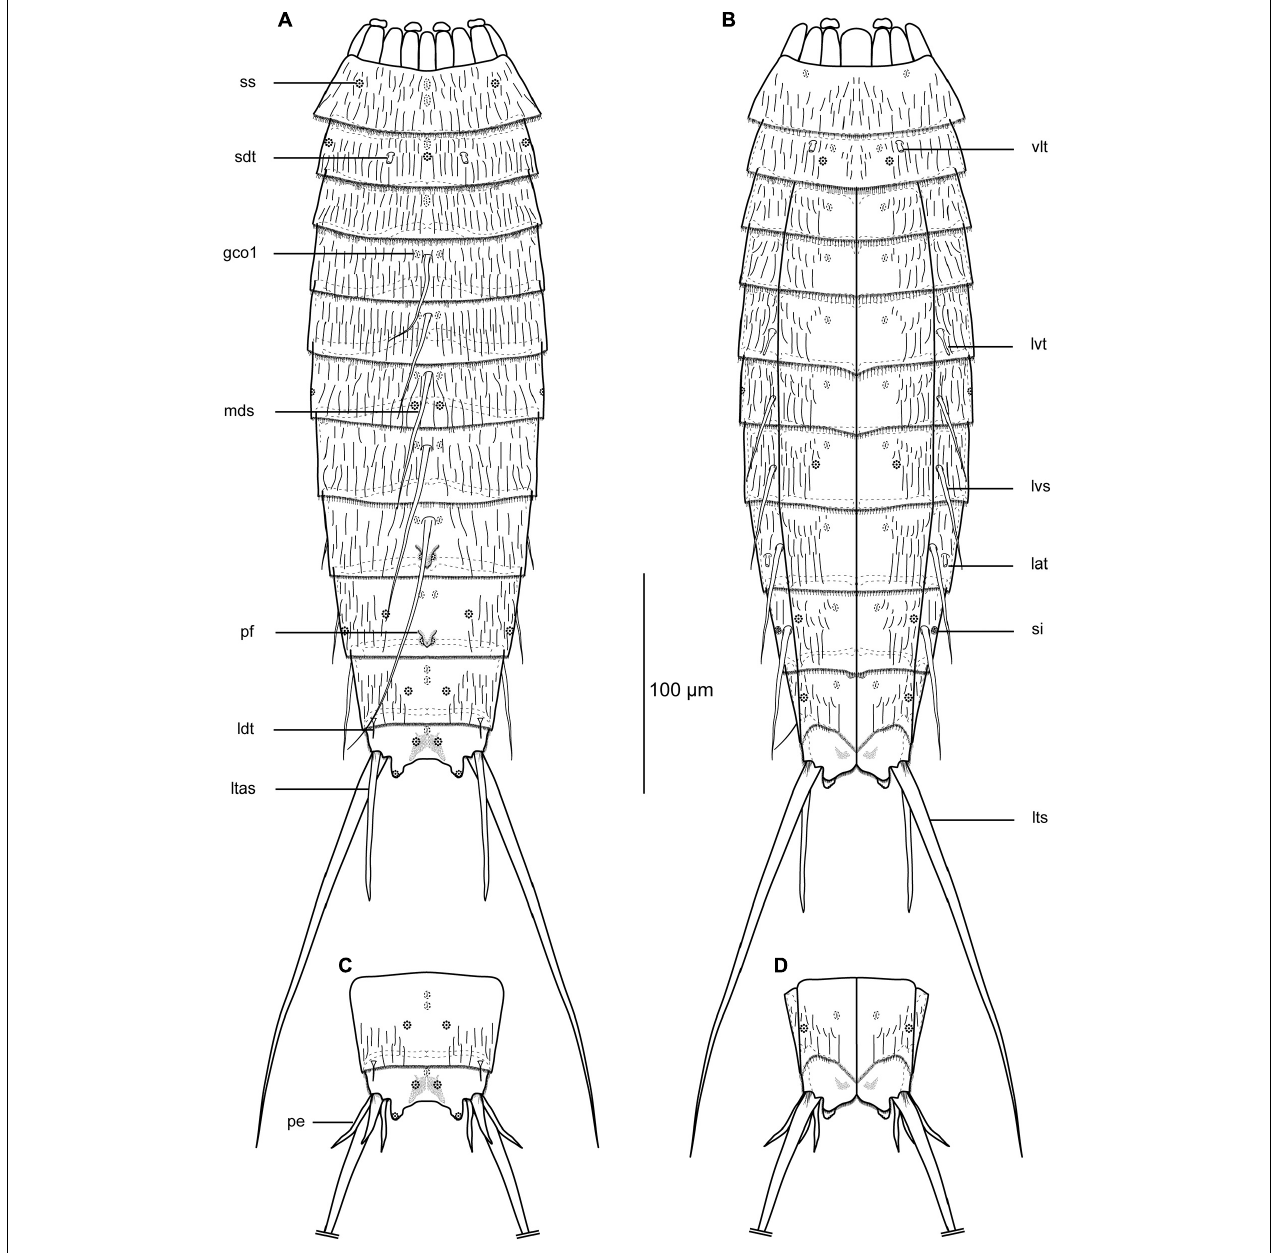
FIGURE 2 | Line art illustrations of Echinoderes mamaqucha sp. nov. (A) female, dorsal view; (B) female ventral view; (C) male, segments 10–11, dorsal view; (D) male, segments 10–11, ventral view. gco1 , glandular cell outlet type 1; lat , lateral accessory tube; ldt , laterodorsal tube; ltas , lateral terminal accessory spine; lts , lateral terminal spine; lvs , lateroventral spine; lvt , lateroventral tube; mds , middorsal spine; pe , penile spines; pf , papillary flap; sdt , subdorsal tube; si , sieve plate; ss , sensory spot; vlt, ventrolateral tube.